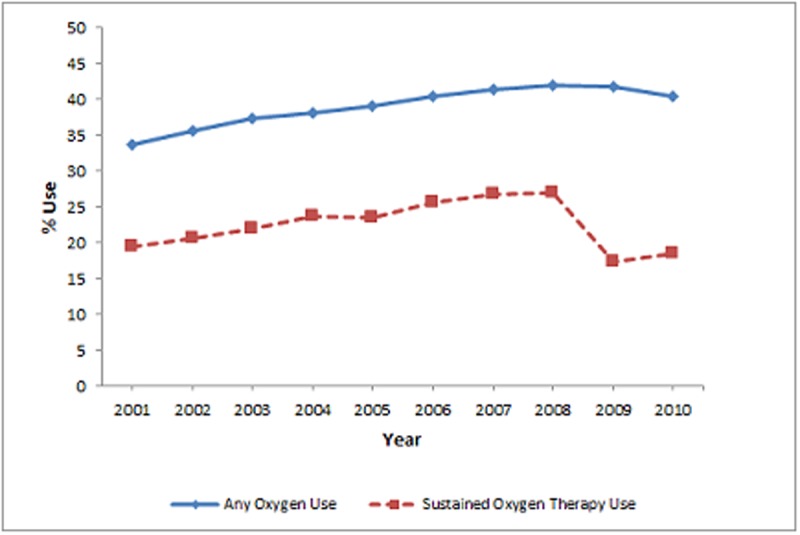
Annual percent of oxygen therapy and Sustained oxygen therapy use from 2001–2010.